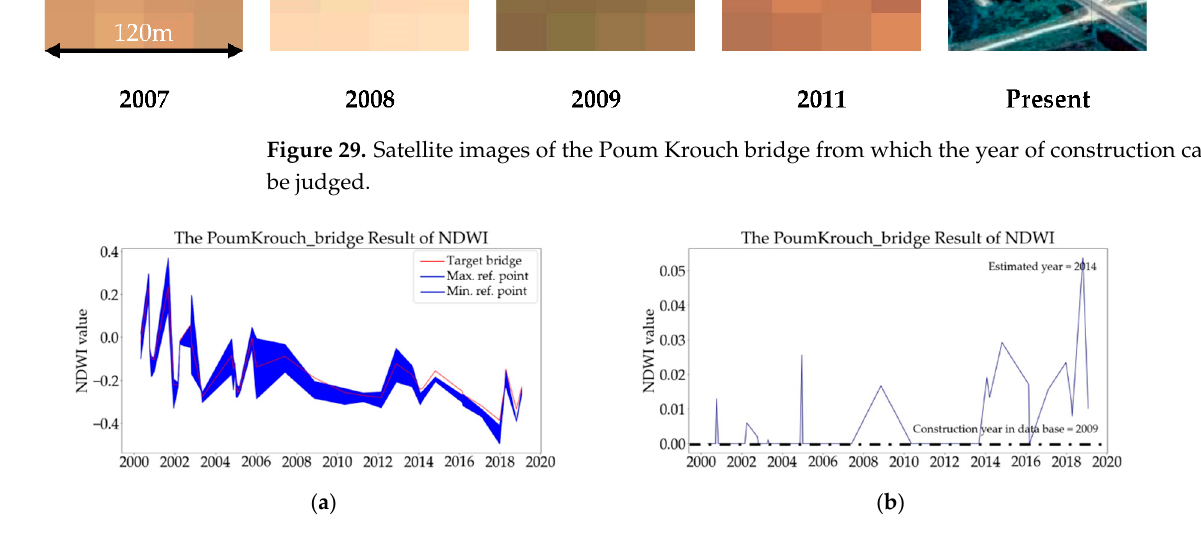
Figure 30. ( a ) NDWI results for the Poum Krouch bridge, from which the year of construction is estimated to be 2014; ( b ) re-visualization of ( a ) showing a sudden NDWI deviation in 2014. The third case of the Ta Kouy1 bridge (L = 5 m) has similar results. The bridge cannot be identified from the satellite images (Figure 31), but the NDWI results give an estimated year of construction of 1993, which is when the red line moves permanently outside the blue shaded region (Figure 32).